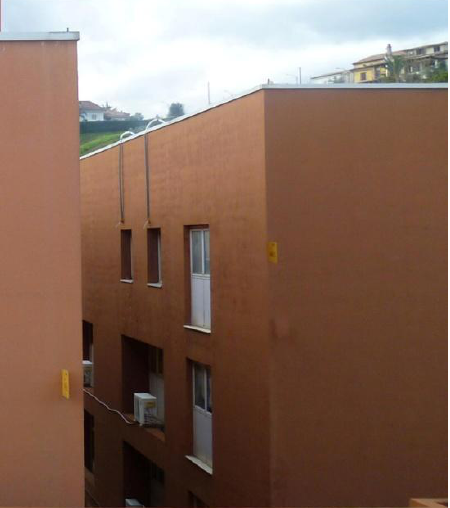
Figure 2. Image with artificial changes and misregistration